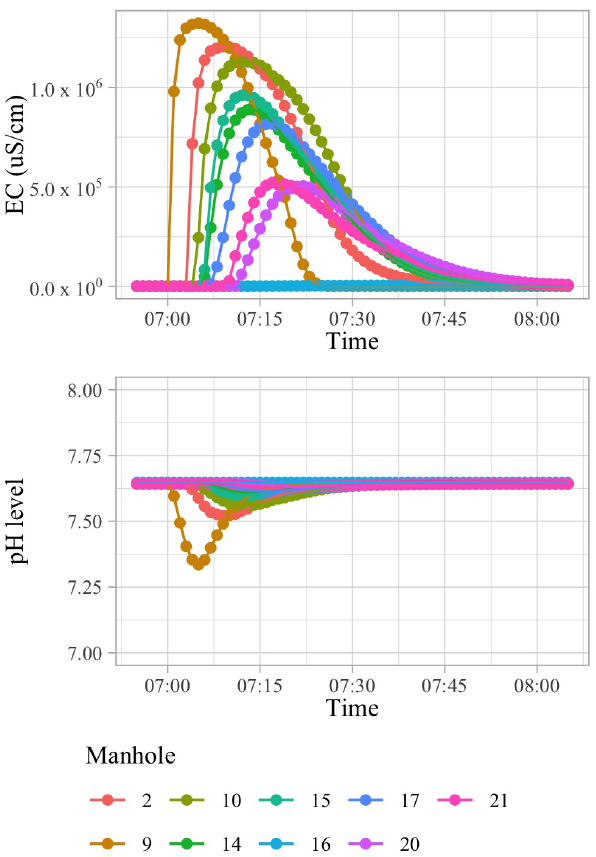
Figure 2. Electrical conductivity and pH peak broadening and flattening caused by dispersion, as seen by different manholes, when one hundred liters of sulfuric acid are discharged at location B13 of Figure